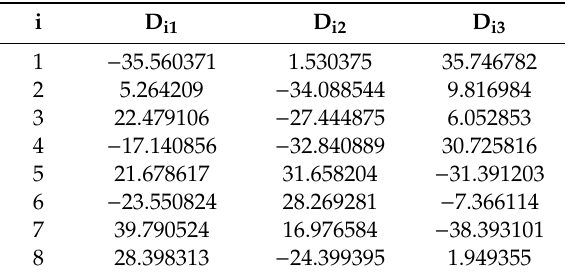
Table 5. Constants (weights and biases) D ij in Equation